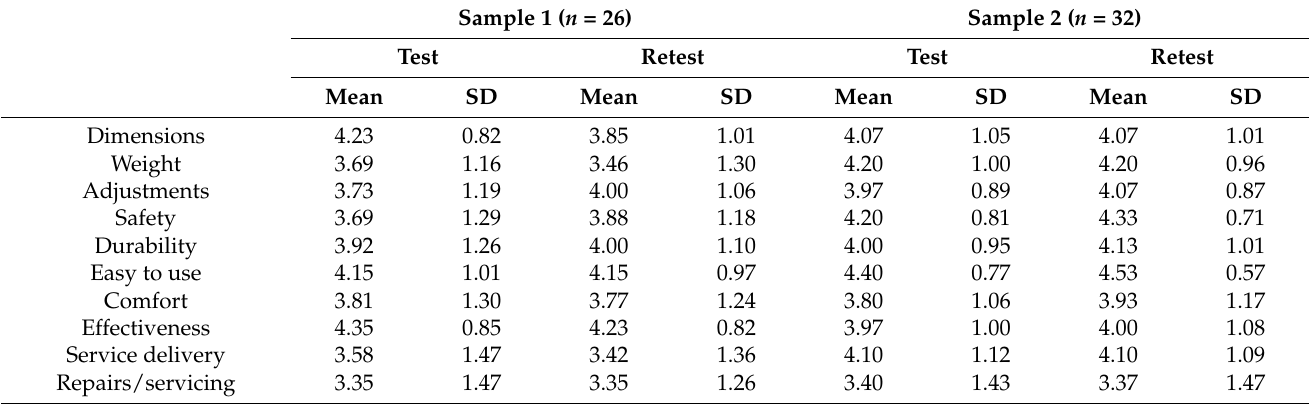
Table 2. Results from the application of QUEST 2.0-ES per item of the